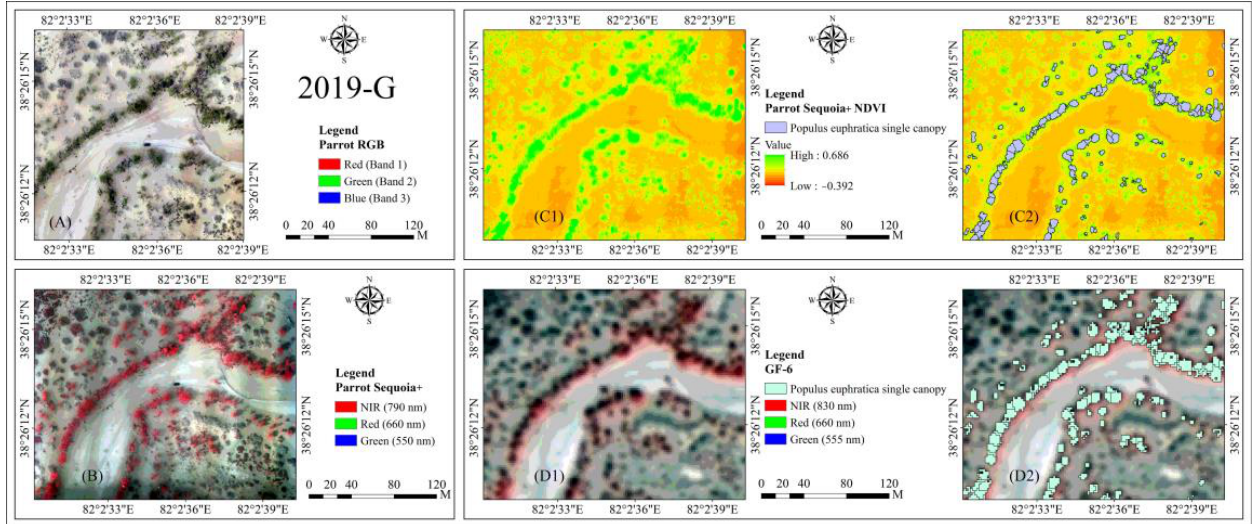
Figure 14. Schematic diagram of the 2019-G validation quadrat. ( A ) Parrot RGB mosaic image. ( B ) Parrot Sequoia+ false color composite image. ( C1 ) Parrot Sequoia+ NDVI image. ( C2 ) Parrot Se- quoia+ NDVI and PeITC extraction vector overlay image. ( D1 ) GF-6 false color composite image. ( D2 ) GF-6 false color composite with PeITC extraction vector overlay